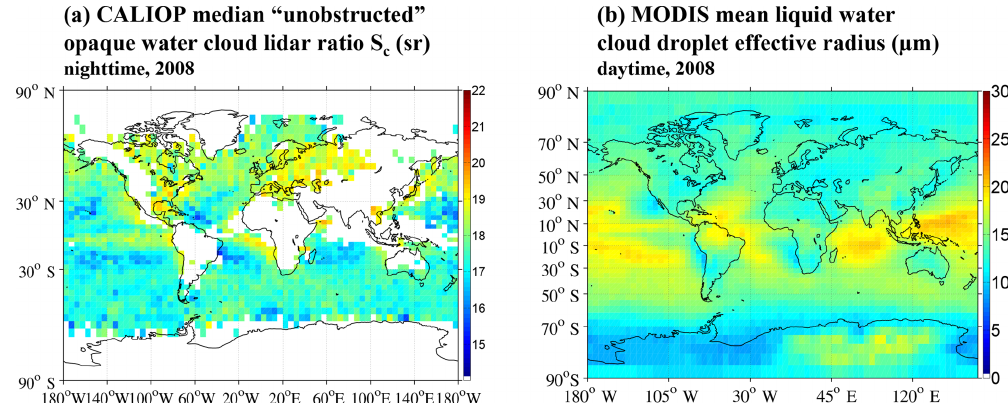
Figure B2. (a) Global CALIOP yearly median nighttime “unobstructed” (i.e., clear air above) OWC lidar ratio, S c , in 2008 that satisfies all criteria of Table B2. For the reasons outlined in this section, any OWC along the CALIOP track for which S c > 20sr or S c < 14sr is deleted before temporal and spatial averaging. White pixels show a limited number of OWCs; (b) Global MODIS yearly mean daytime liquid water cloud droplet effective radius, R e (in µm, “Cloud Effective Radius Liquid Mean Mean” parameter from MODIS MYD08_M3